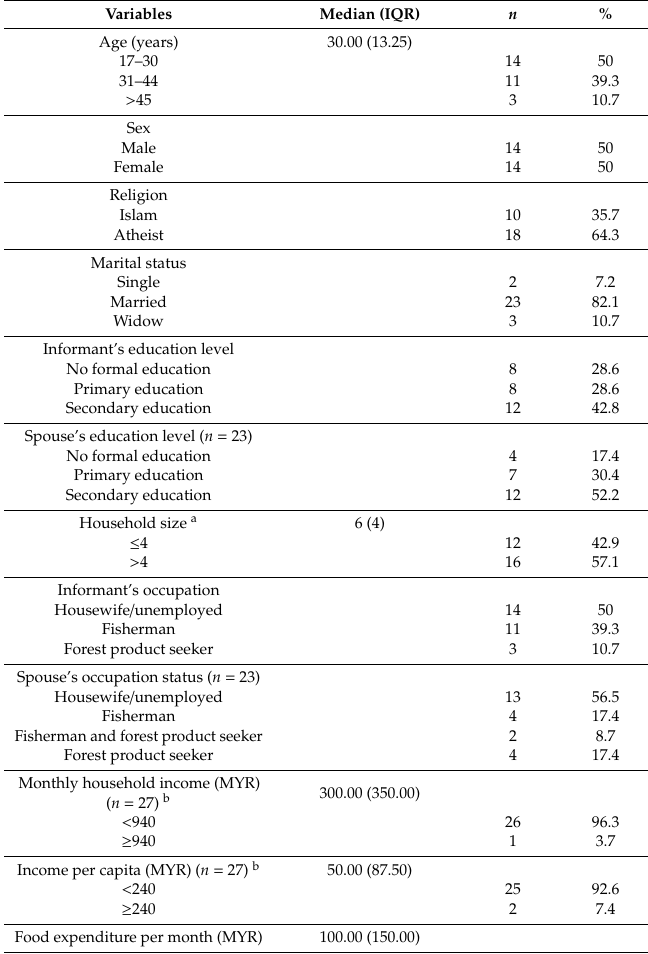
Table 1. Background of the informants ( n =